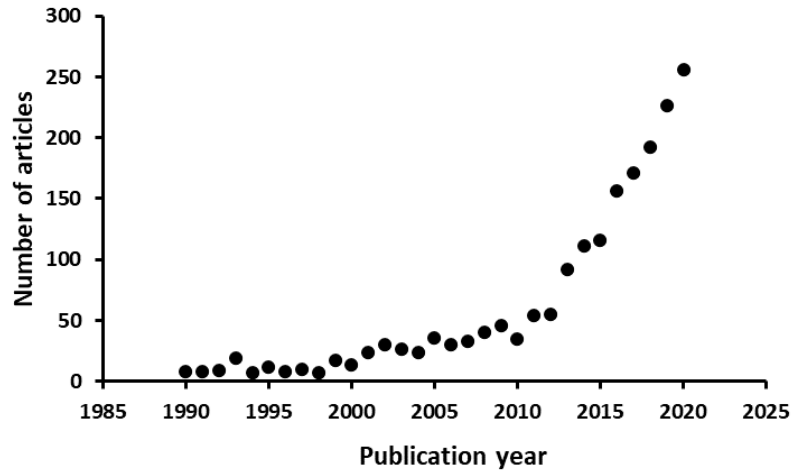
Figure 1. Number of published documents in Scopus from 1990 to 2020 with the term ‘food fraud’ within the article title, abstract and/or keywords.